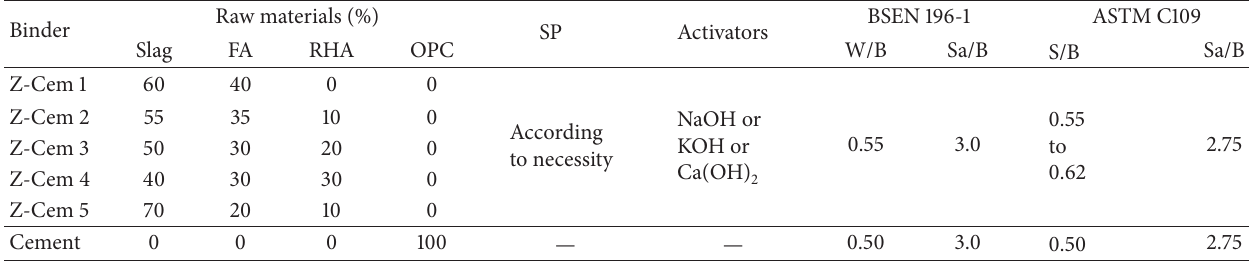
Table 1: Materials used for the preparation of Z-Cem and OPC mortars